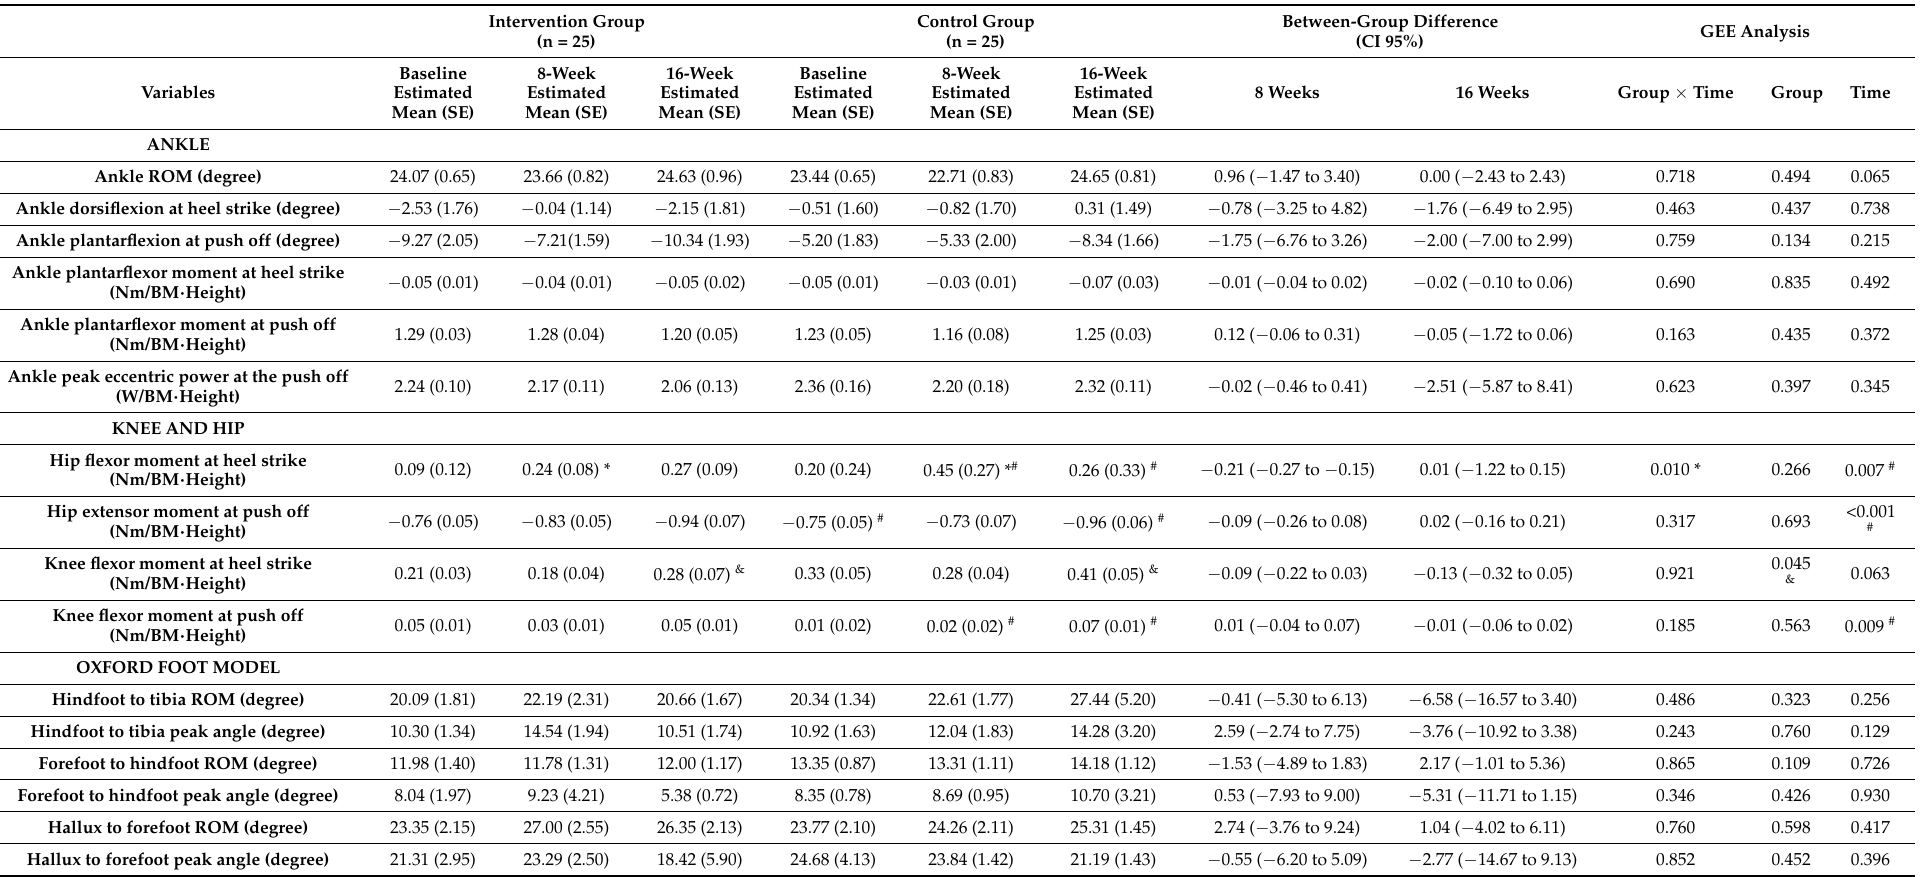
Table 4. Estimated mean (standard error, SE), p -values of the interaction, group and time effects, and between-group mean difference at 8 and 16 weeks (95% confidence interval) of the foot–ankle kinematics and hip, knee, and ankle joint moments during gait for each group (control and intervention) at three assessments (baseline, 8, and 16